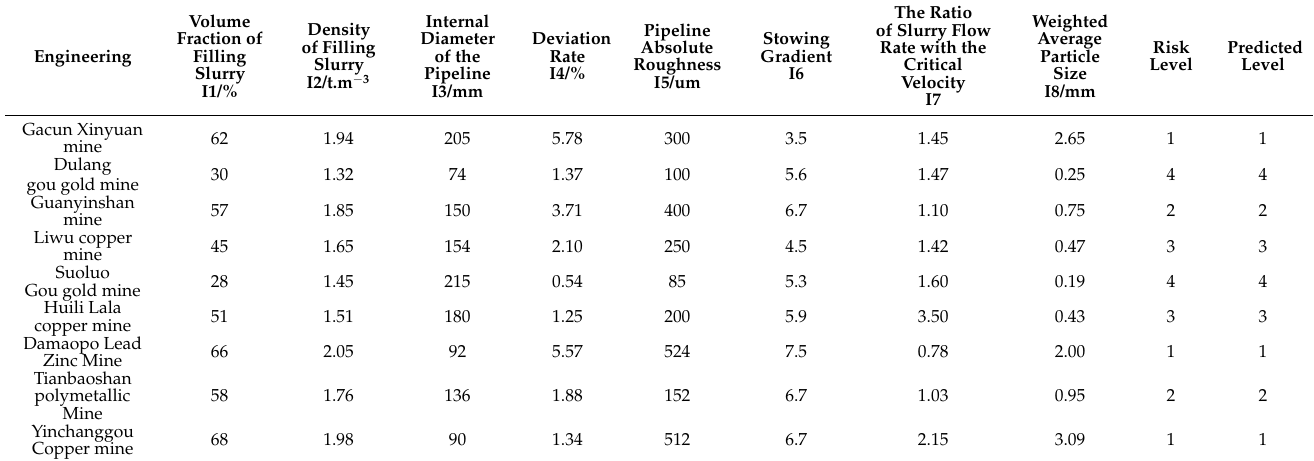
Table 4. Application of the WOA–RF model in practical